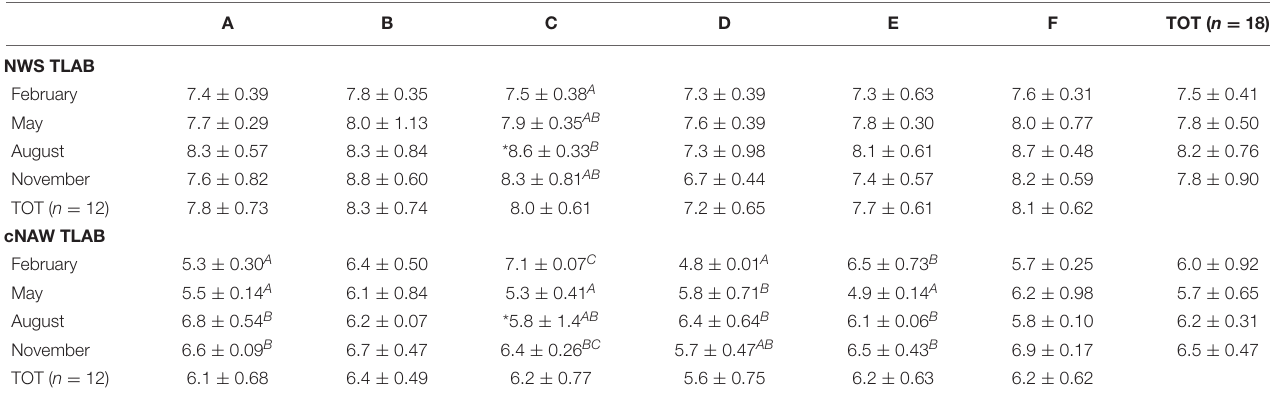
TABLE 1 | Thermophilic lactic acid bacteria (TLAB) counts onto WAM of Trentingrana NWS and